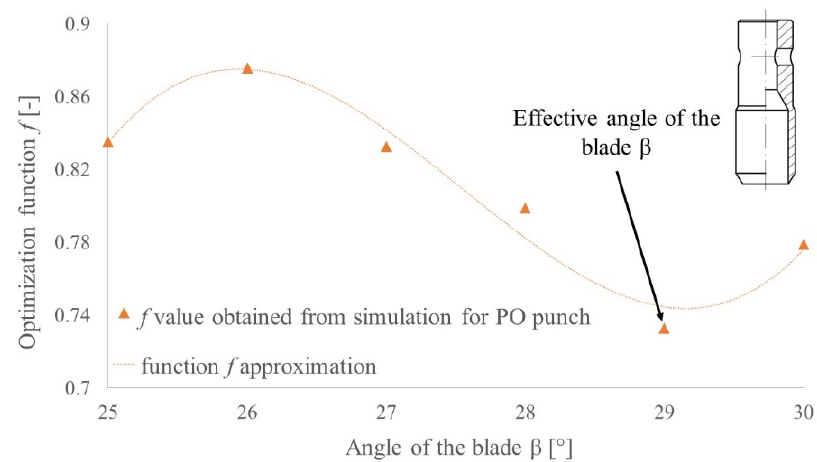
Figure 22. The optimization function for PO punch with diameter d = 10 mm and height of the blade H = 2.65 mm for belt TFL10S and for angle of the blade in range of 25°–30°.